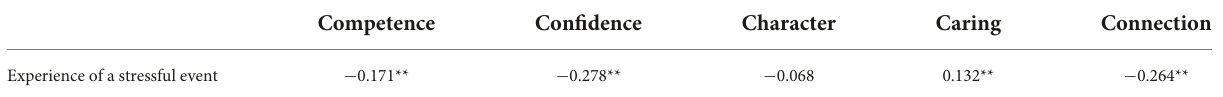
TABLE 4 Correlations between the five Cs and stressful events ( N =